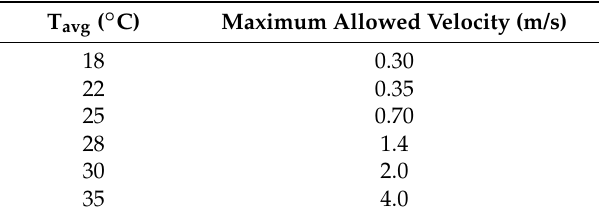
Table 6. EN-14750-1 velocity requirements depending on the average temperature (category B).